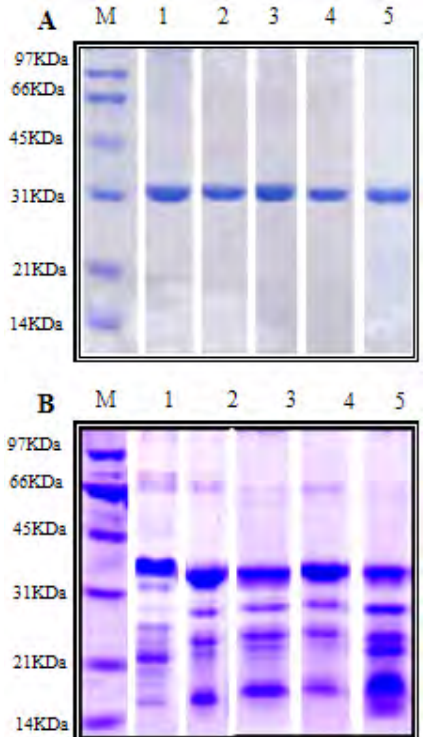
Figure 1: SDS-PAGE analyses of polyhedra (A) and ODVs (B) of AcAaIT (lanes 1), AcAaIT-laboratory (lanes 2), AcAaIT-field (lanes 3), AcMNPV (lanes 4), and SlNPV (lanes 5). The molecular weight of size standards (lanes M) are indicated to the left.